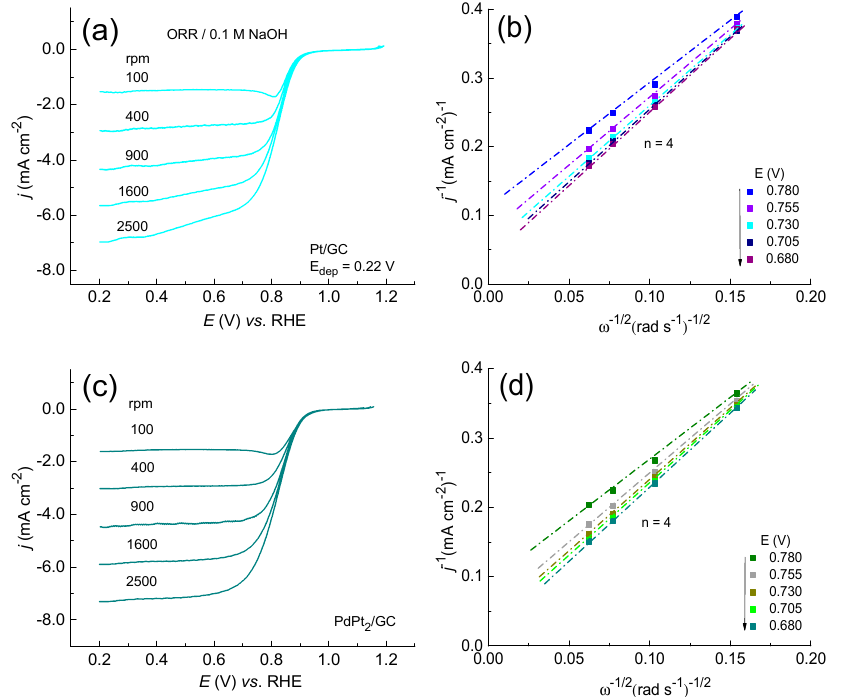
Figure 9. Polarization curves for ORR in 0.1 M NaOH on ( a ) Pt/GC; ( b ) Corresponding K–L plot; ( c ) PdPt 2 /GC; and ( d ) corresponding K–L plot. Scan rate 50 mV s − 1 . Figure 10a shows the polarization curves for the ORR on the PdPt 2 /GC and Pt/GC electrodes at the same rotation rate of 1600 rpm, where the current densities are given relative to the geometric area of electrodes. The polarization curve for Pt(poly) is given for comparison.